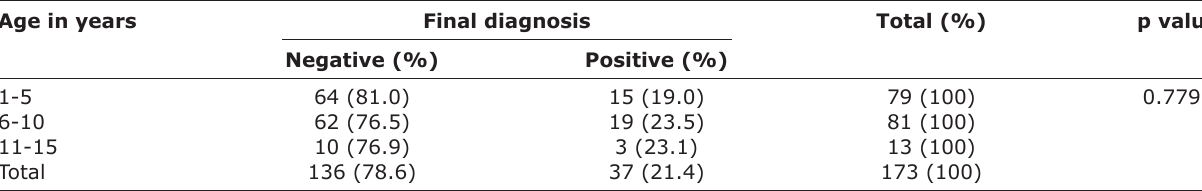
Table-6: Prevalence of bovine tuberculosis in cattle of different age